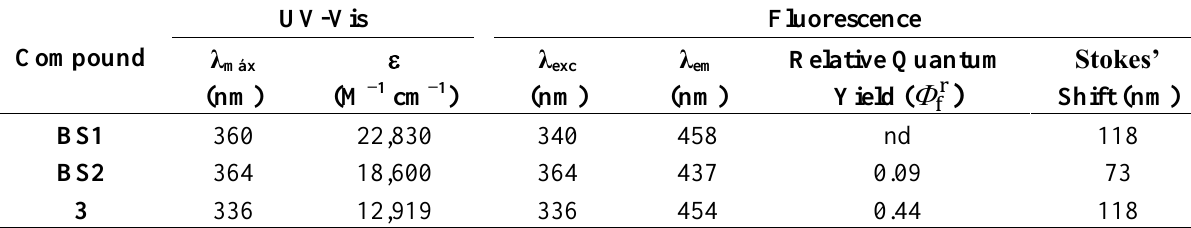
Table 1. Emission and excitation spectrum-related data of tested compounds.